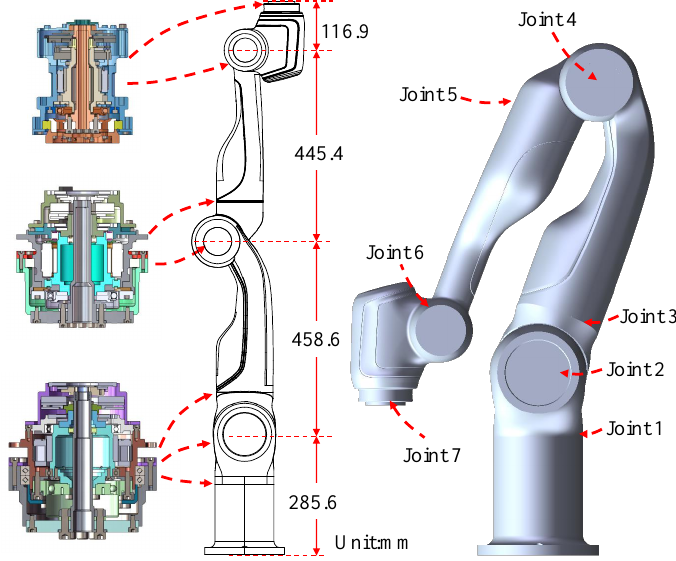
Figure 3. Structural form of the